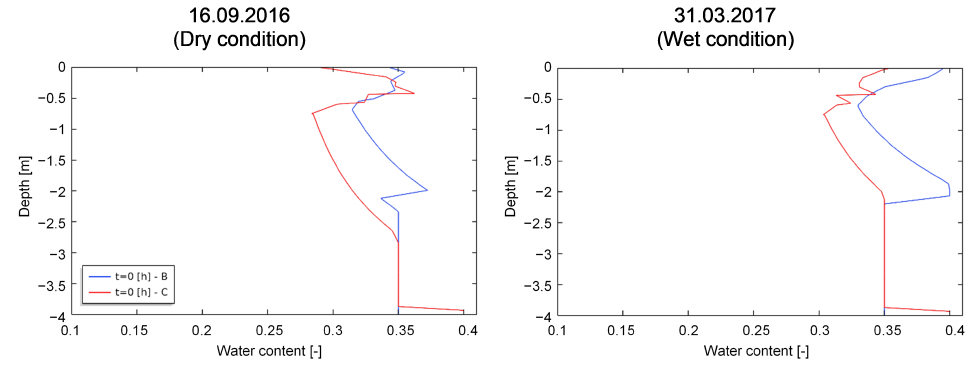
Figure 10. The initial saturation ( a , b ) and LFS distribution ( c , d ) for the rainfall simulations on 30 September 2016 and 31 March 2017.